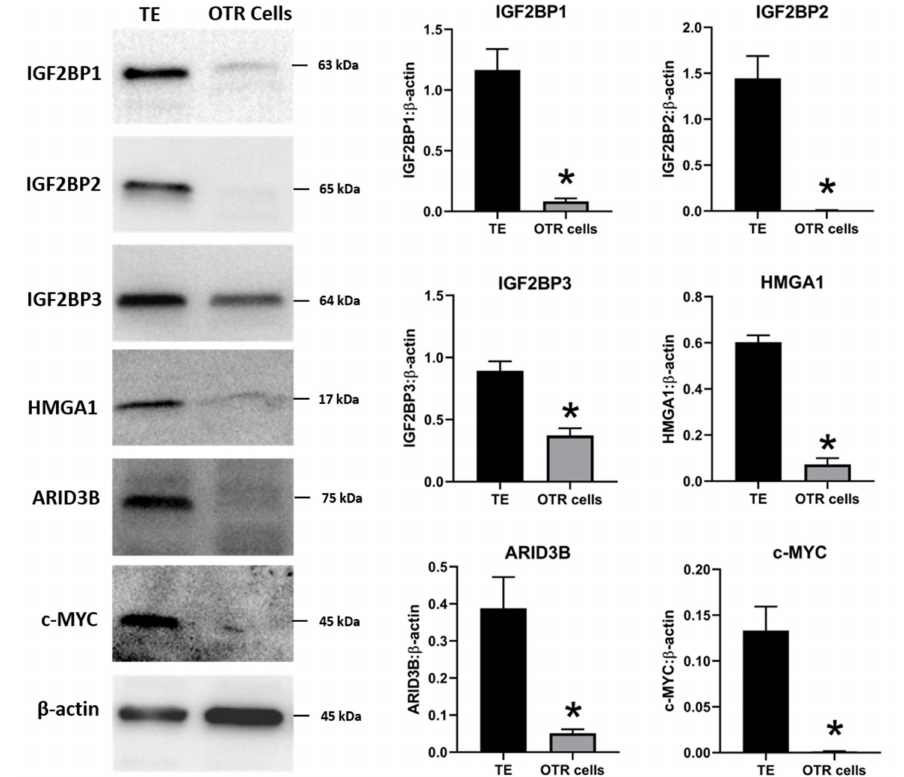
Figure 7. Representative immunoblots for IGF2BP1, IGF2BP2, IGF2BP3, HMGA1, ARID3B, c-MYC, and β -actin, and densitometric analysis of immunoblotting results in OTR cells compared to day 16 TE ( n = 3), * p < 0.05 vs.